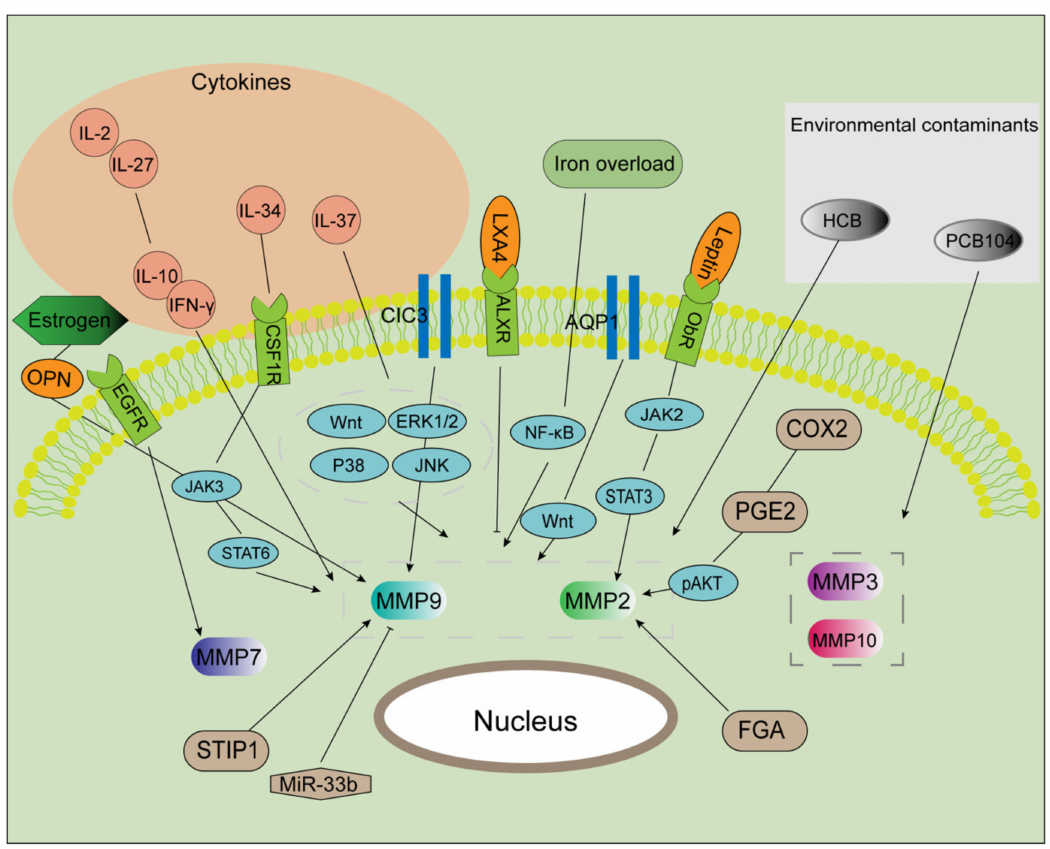
Figure 1. Multiple factors regulate MMP activities. After exposure to certain environmental contaminants (e.g., PCB104 and HCB), the expression of MMPs (MMP3, 10, 2, and 9) is markedly enhanced. IL-37 upregulates the expression of MMPs via multiple signaling pathways. IL-2 and IL-27 were found to maintain the balance of IL-10 and IFN- γ , promoting MMP2